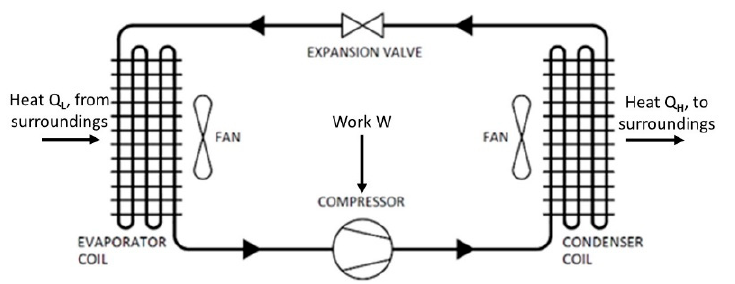
Figure 2. The schematic of a basic refrigeration cycle.